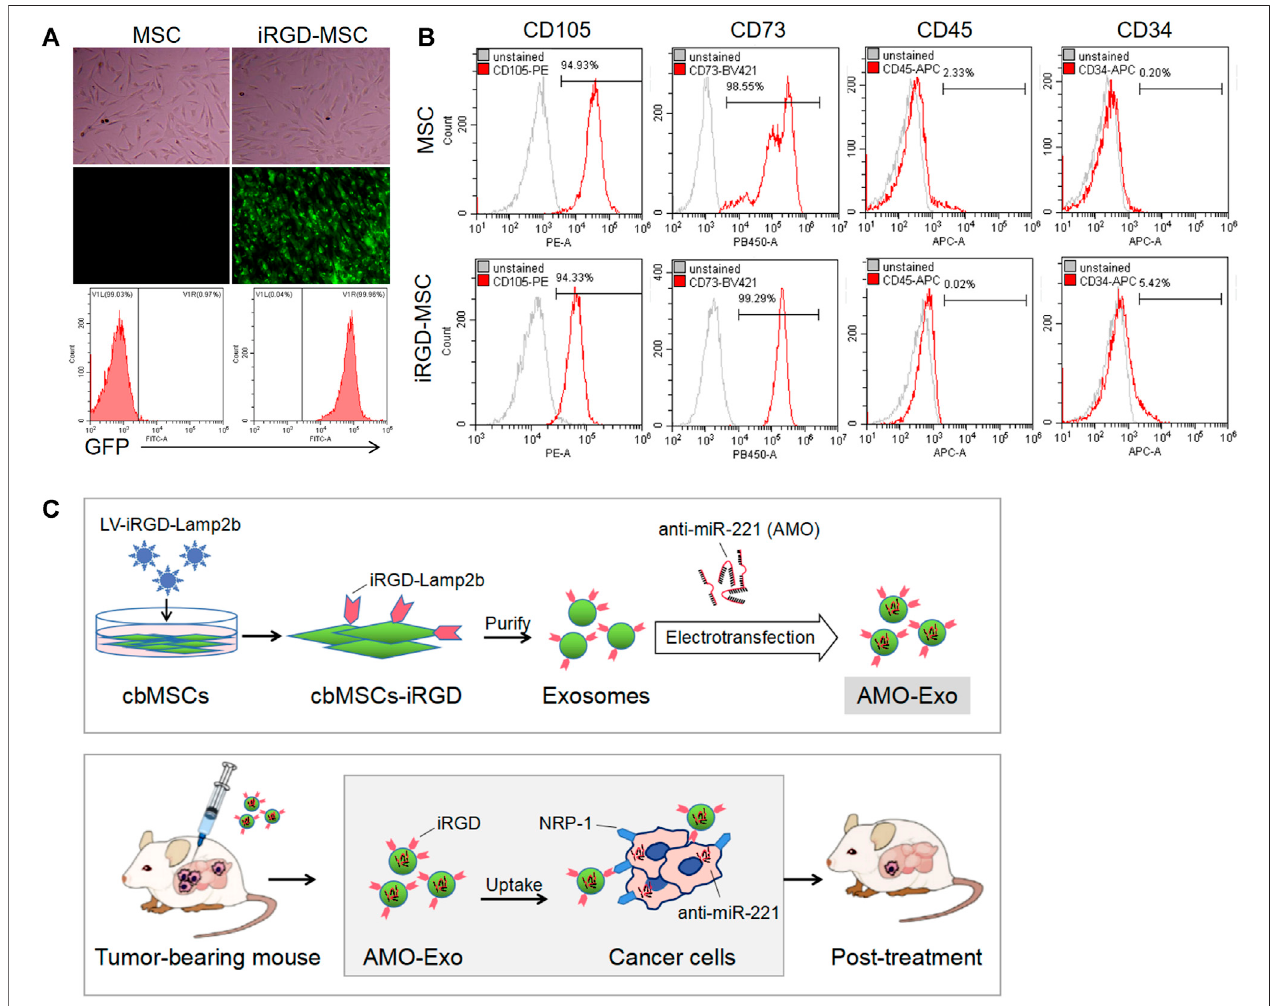
FIGURE 1 | Production and identi fi cation of MSC-derived exosomes (A) Cell morphology and GFP expression of mesenchymal stem cells. (B) The expression of molecular markers on the surface ofmesenchymal stemcells after iRGD peptide modi fi cation was detected by fl owcytometry. (C) Schematic diagram ofthe anti-tumor mechanism of exosomal drug